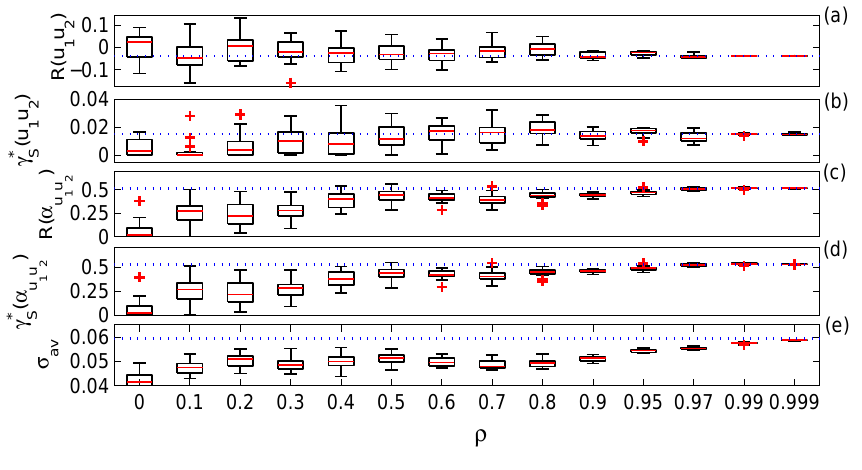
Fig. 11. Gradual wavelet reconstruction for the H¨older series of the two components of the velocity data from Fig. 1. The measures used are the correlation between the velocity series (a) and H¨older series (c) , the phase synchronisation between the velocity series (b) and the H¨older series (d) , and the average standard deviation of the H¨older series (e)